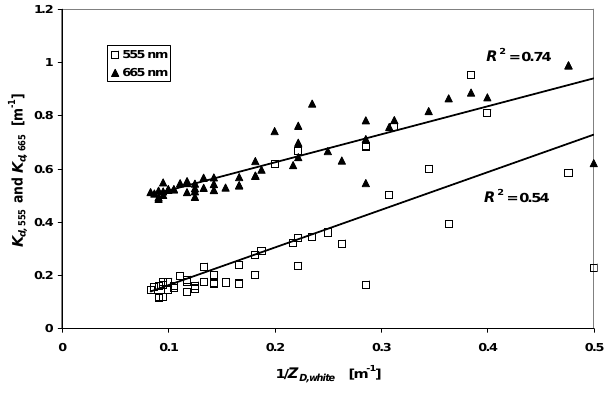
Fig. 7. K d at 555nm and 665nm as a function of 1 /Z D,white . The upper best-fit line is the function K d , 665 = [0.41m − 1 ] + 1.1 /Z D,white and the lower line is K d , 555 = [0.02m − 1 ] + 1.4 /Z D,white